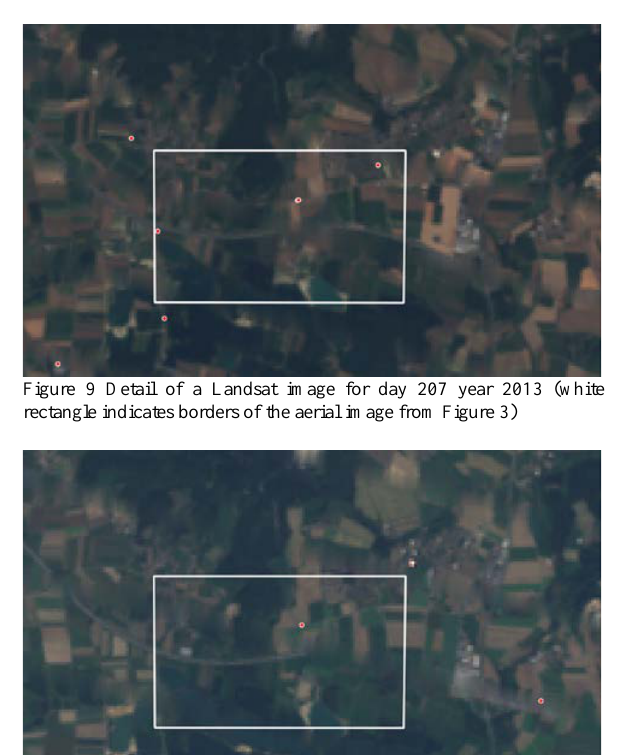
Figure 8 Detail of a Landsat image for day 063 year 2013 (white rectangle indicates borders of the aerial image from Figure 3)